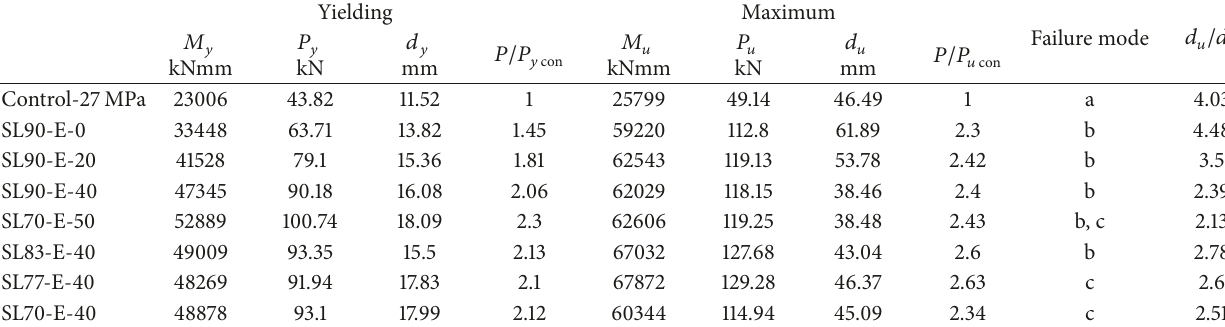
Table 3: Summary of experimental results.